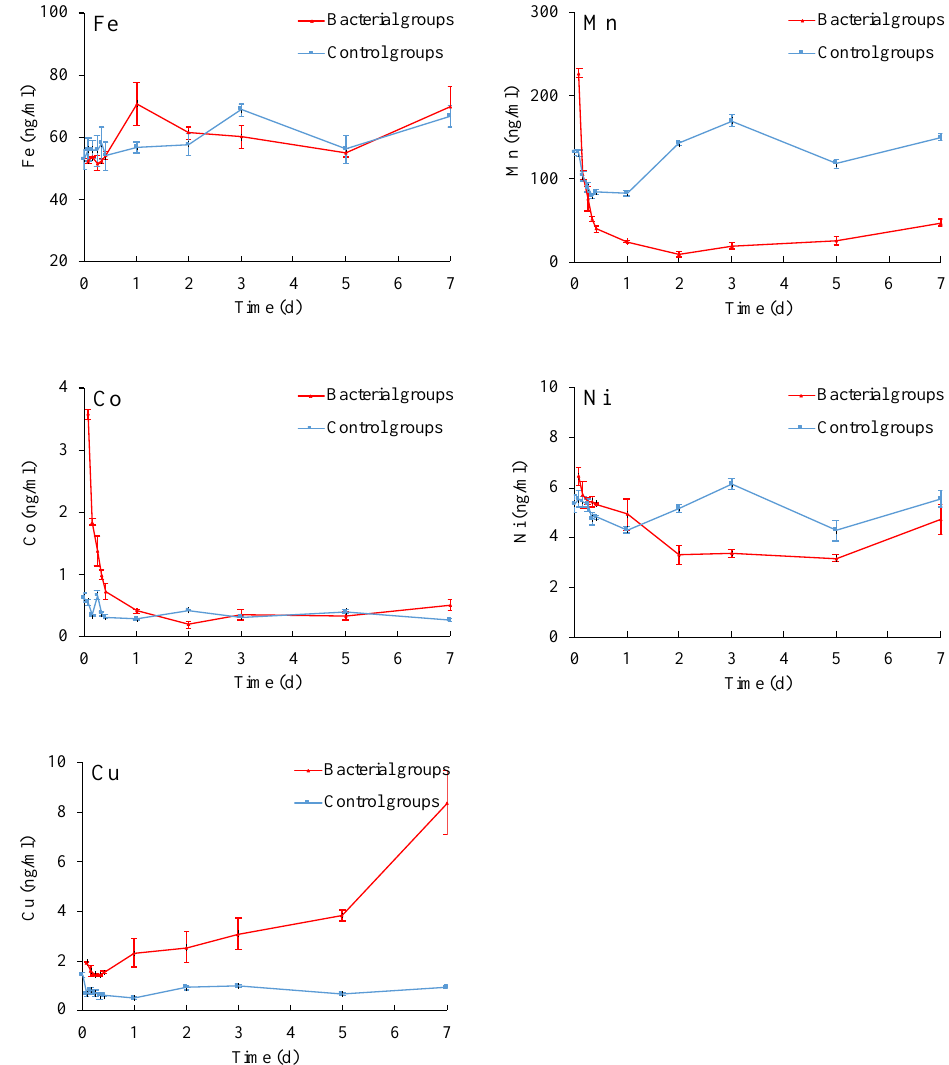
Table 2. Combined with the results of ion concentration and statistical test, the changes of ion concentration were speculated as follows: